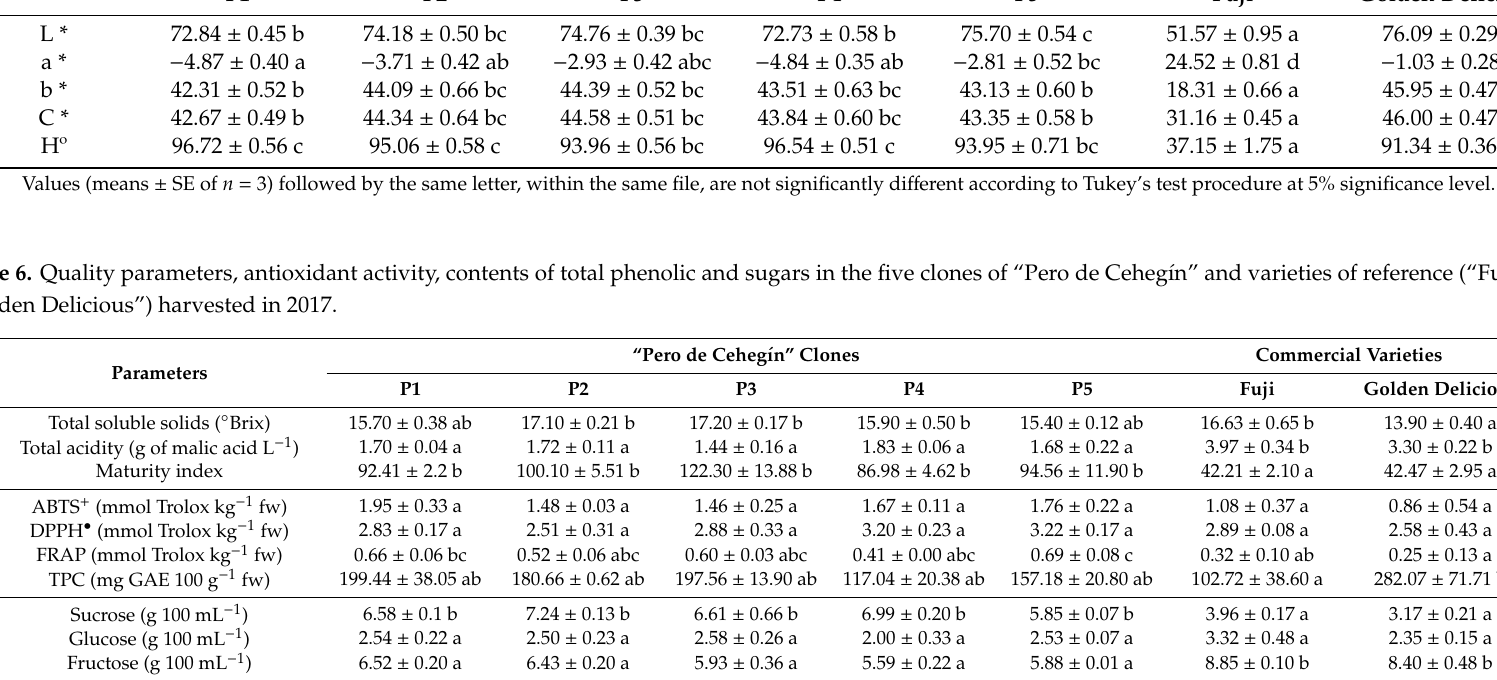
Table 5. Color coordinates (CIEL * a * b *) in the five clones of “Pero de Ceheg í n” and varieties of reference (“Fuji” and “Golden Delicious”) harvested in 2017. Parameters